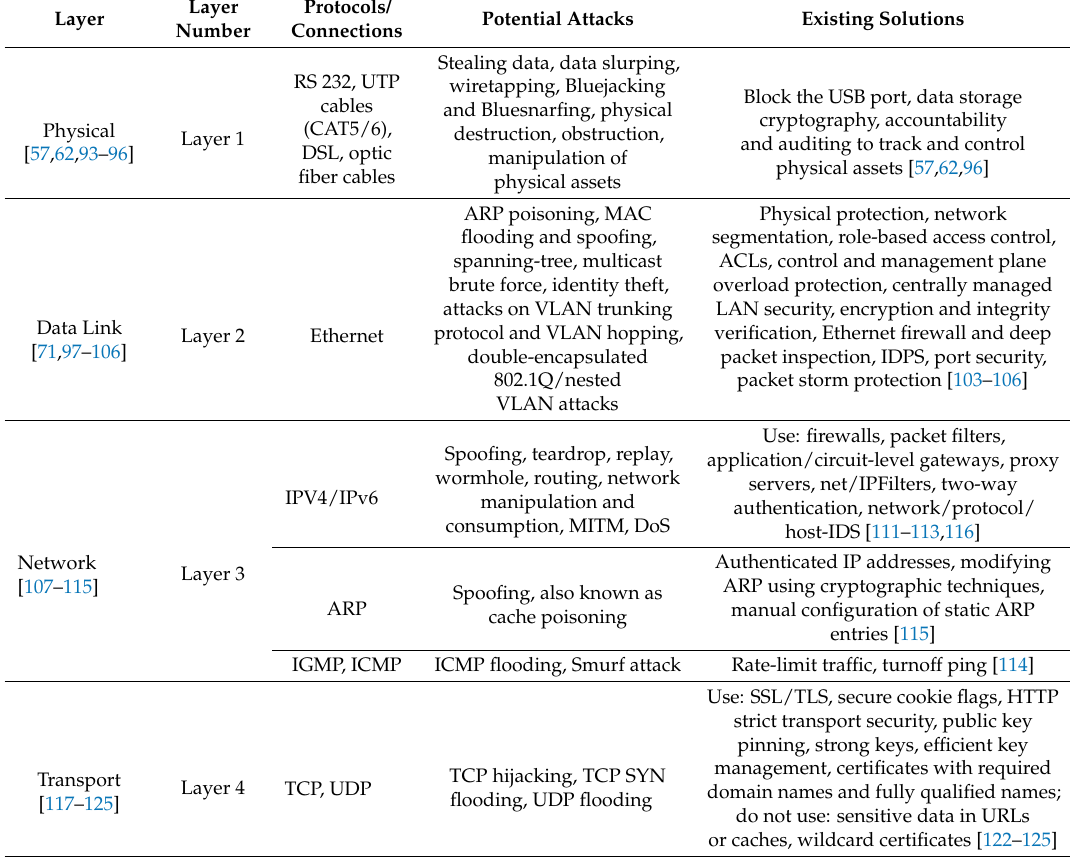
Table 2. A Summary of DER Communication-Level Attacks and Existing Solutions Layers